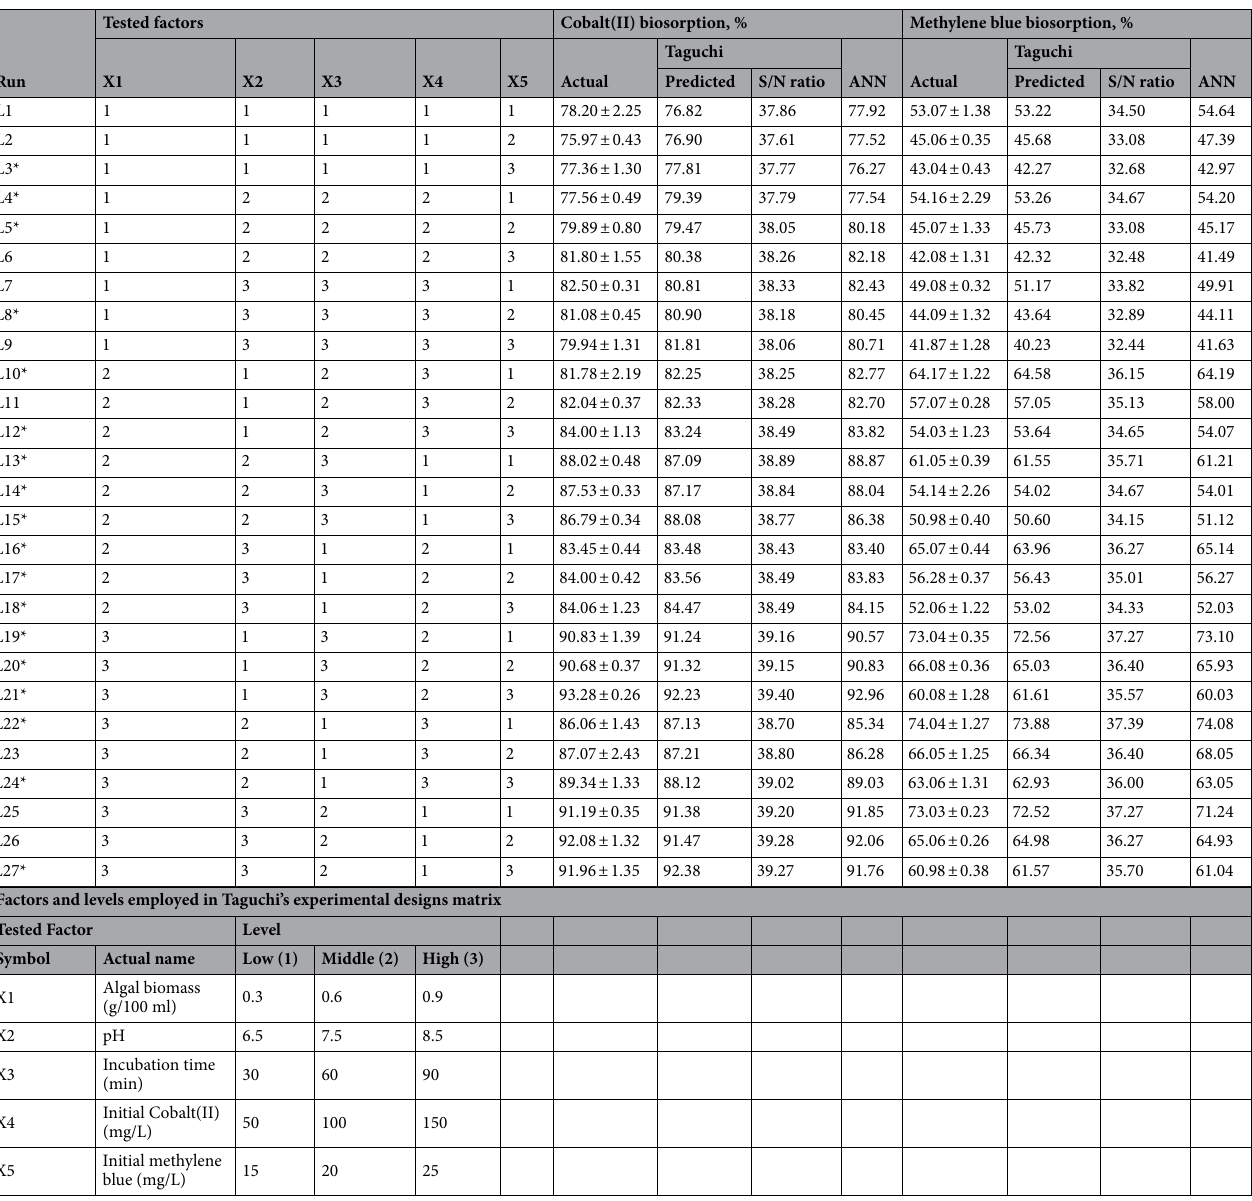
Table 1. Design of Taguchi’s L 27 (3 5 ) orthogonal array for maximization of both Cobalt(II) and MB biosorption, using the biomass of Sargassum latifolium , accompanied by the Taguchi-predicted values and their S/N ratio as well as, the ANN-predicted values at each data point. *The 18 runs that were used for training of the network, the other runs were used for the validation